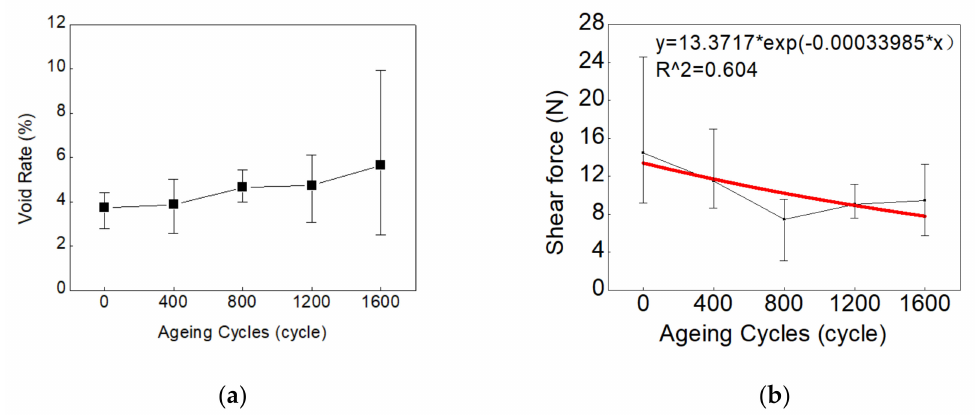
Figure 2. ( a ) The void rates in solder joints of LED chip-scale packaging (CSP) and ( b ) the shear forces of solder joints vs. ageing